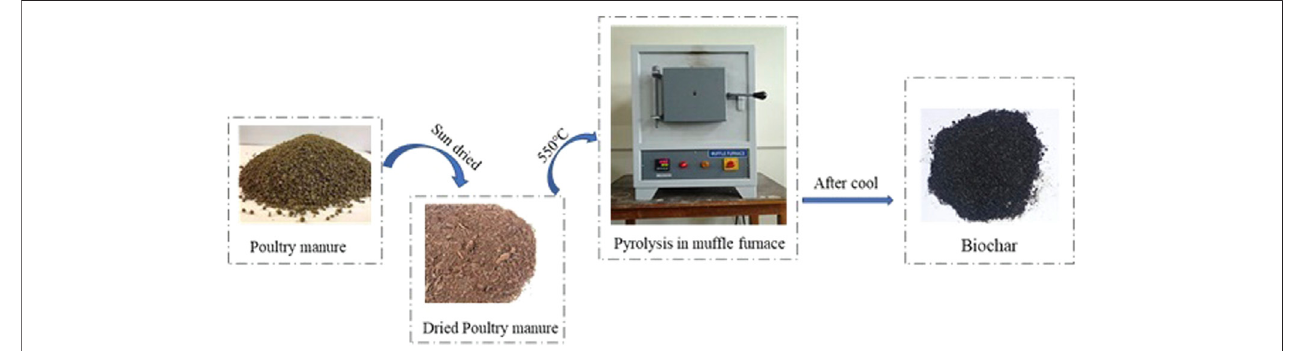
FIGURE 1 | Synthesis of the poultry manure biochar